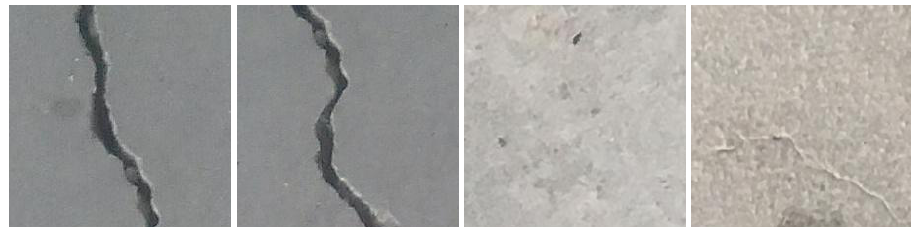
Figure 2. Sample crack and non-crack images of the CCIC dataset.